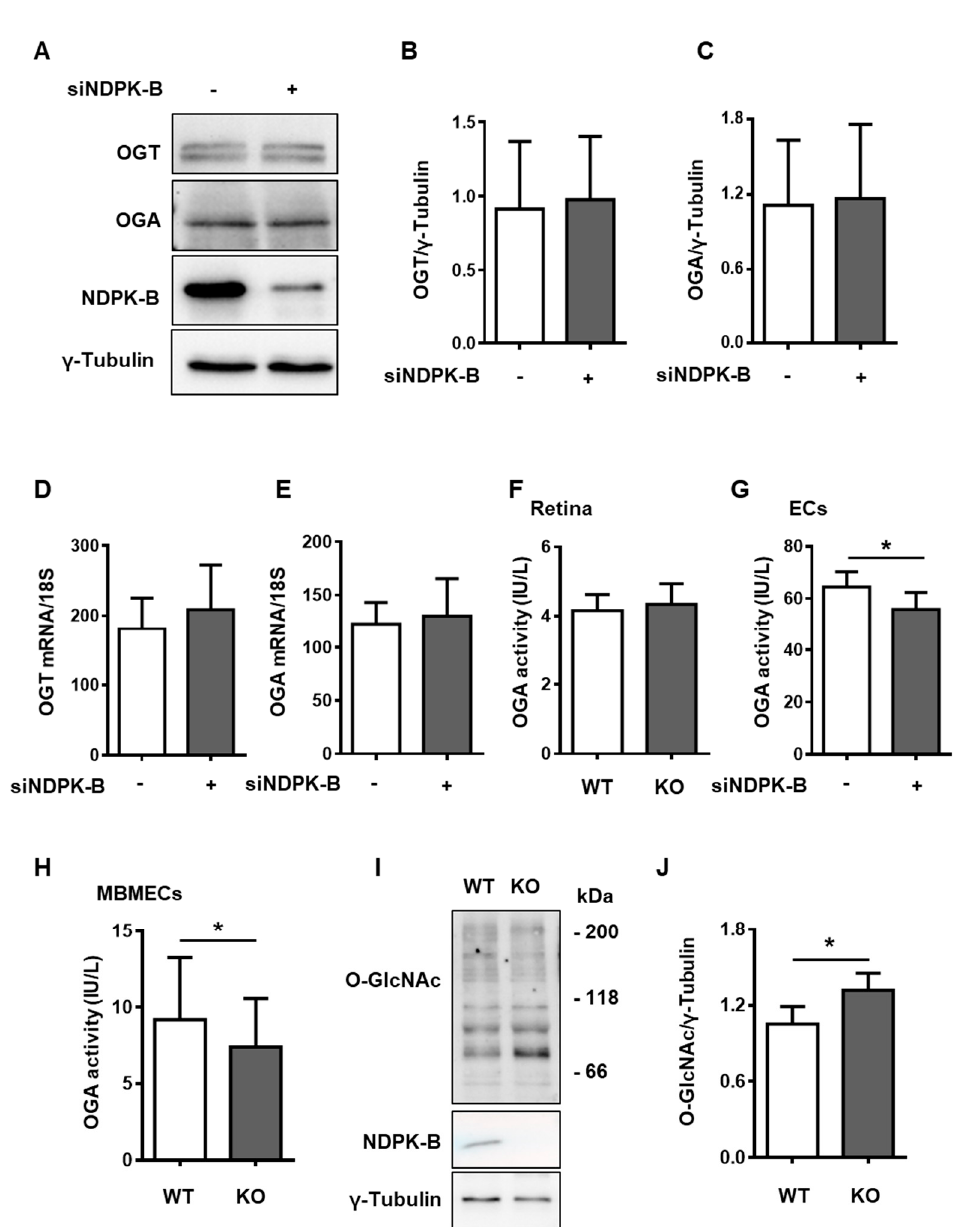
Figure 4. The reduction of OGA activity contributes to enhanced protein O-GlcNAcylation in NDPK-B-depleted ECs. ( A ) HUVECs transfected with either scrambled control ( − ) or siRNA against NDPK-B (siNDPK-B, + ) were analyzed for OGT, OGA, and NDPK-B content by immunoblotting (n = 9). ( B ) Quantification of OGT and ( C ) OGA relative to loading control, γ -tubulin. ( D ) mRNA levels of OGT and ( E ) OGA relative to 18S quantified by qPCR (n = 6). OGA activity in ( F ) WT and KO retinae isolated from 5-month-old male mice (n = 8 mice per genotype), ( G ) lysates of control and NDPK-B knockdown HUVECs (n = 7) and ( H ) lysates of WT and KO MBMECs isolated from 10–15-week-old WT and KO mice. ( I ) NDPK-B and protein O-GlcNAc content analyzed by immunoblot in the same lysates of WT and KO MBMECs. ( J ) Quantification of protein O-GlcNAcylation relative to γ -tubulin (n = 5). MBMECs were prepared from 3–4 animals per genotype. WT: wild type; KO: NDPK-B knockout; OGT: O-GlcNAc transferase; OGA: O-GlcNAcase; MBMECs: murine brain microvascular ECs. Results are presented as mean ± SD. *: p < 0.05.